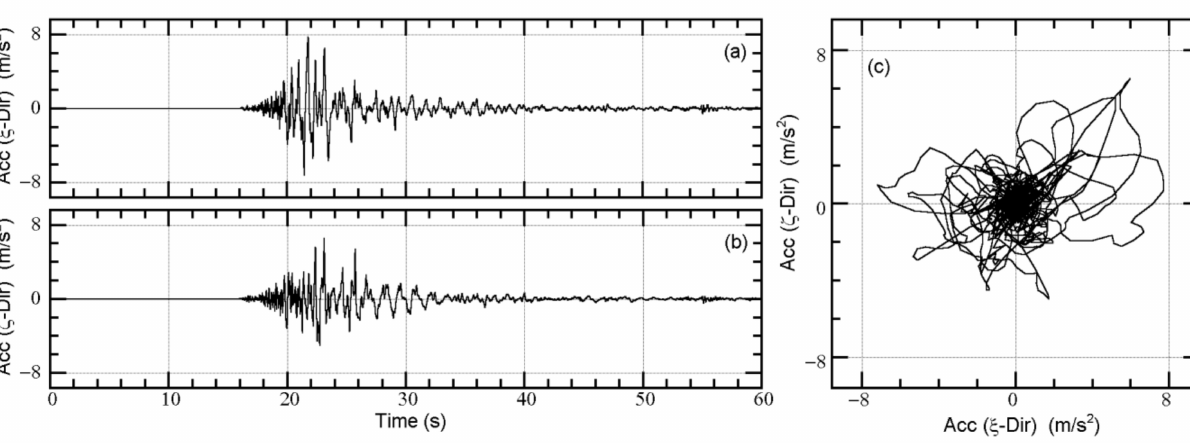
Figure A2. Two components of the recorded ground motion (UTO0416): ( a ) ξ direction; ( b ) ζ direction; ( c )